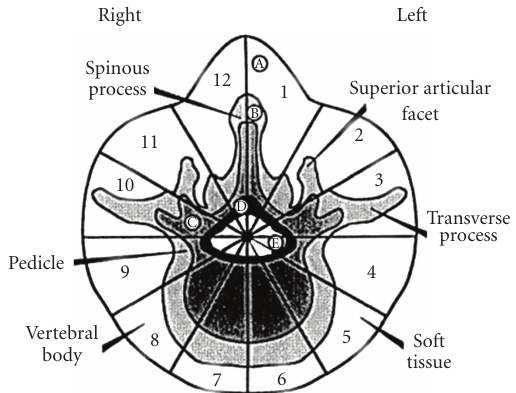
Figure 6: Weinstein-Boriani-Biagini surgical staging for spinal tumors, the transverse plane, and into five layers (A to E, from the paravertebral extraosseous region to the dural involvement). [40]. (A) Extraosseous (soft tissues), (B) intraosseous (superfi- cial), (C) intraosseous (deep), (D) extraosseous (extradural), (E) extraosseous (intradural), and (M)